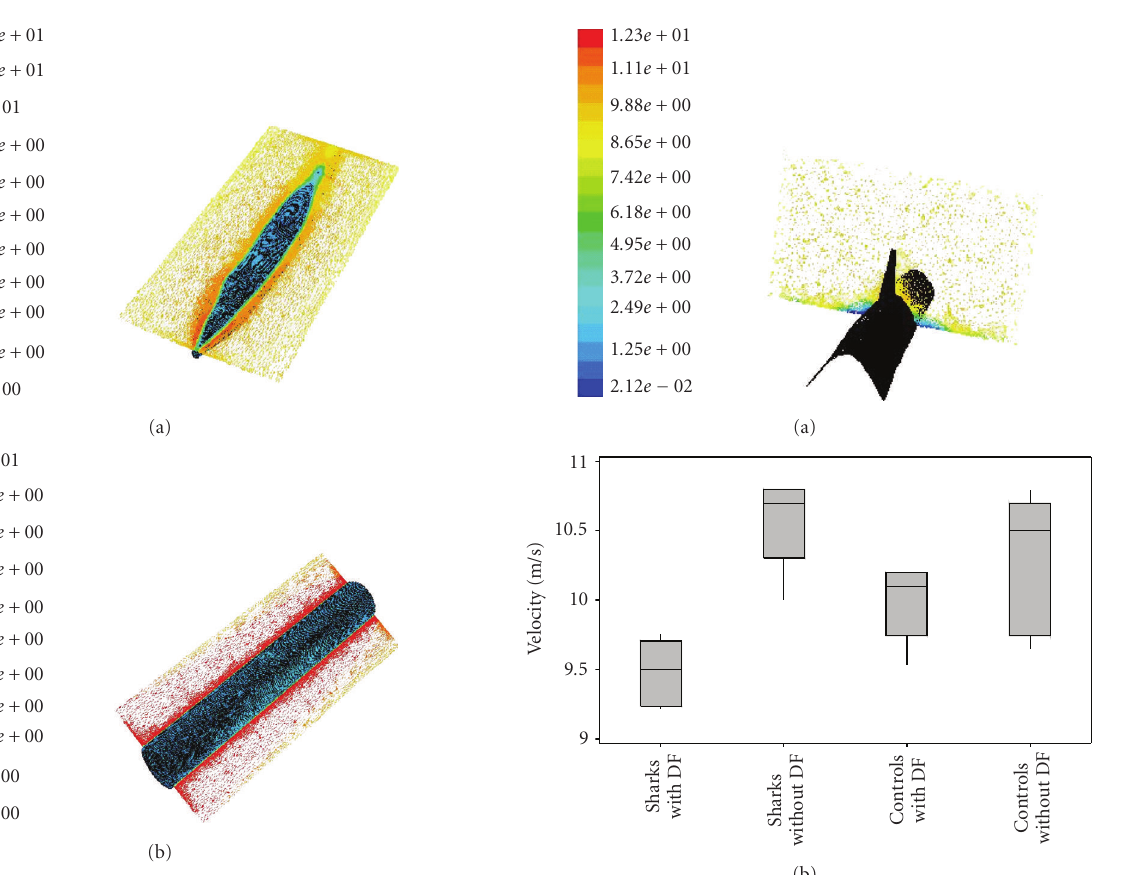
Figure 7: (a) Velocity vectors (coloured by magnitude in m s − 1 ) around the dorsal fin section of specimen C (with dorsal fin attached). Reduced velocities were described along the lateral line adjacent to the trailing edge of the fin. (b) Mean velocity along the lateral line adjacent to the trailing edge position of the dorsal fin (DF) in shark body and control models with and without the dorsal fin attached.